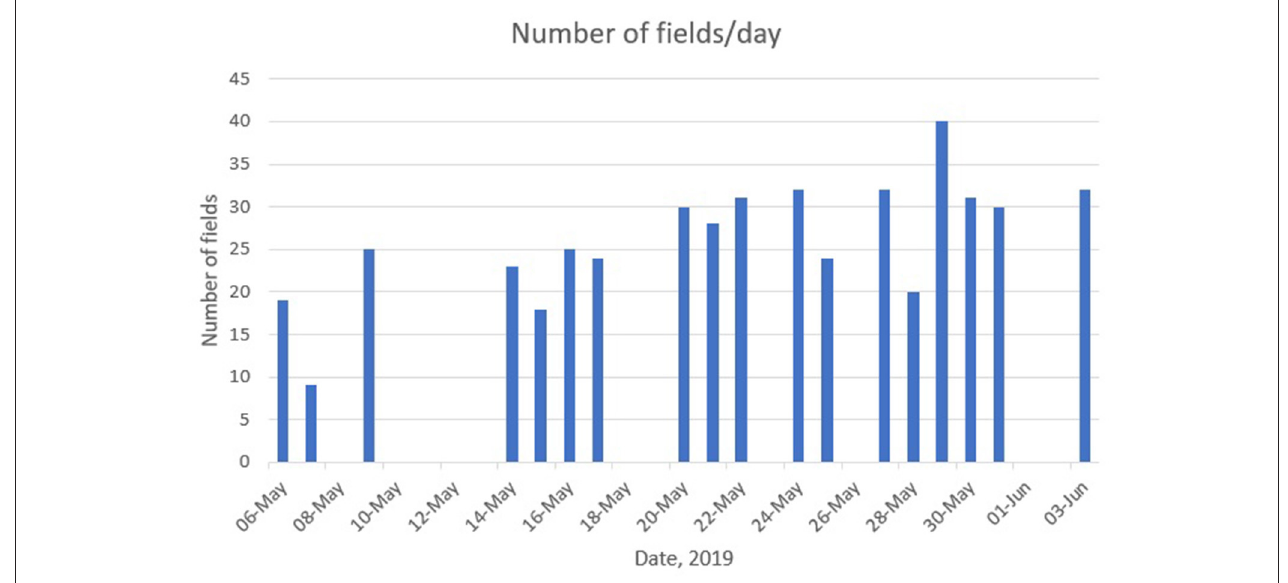
FIGURE 1 | Number of fields surveyed each day between May 6th and June 3rd, 2019 in Busia,